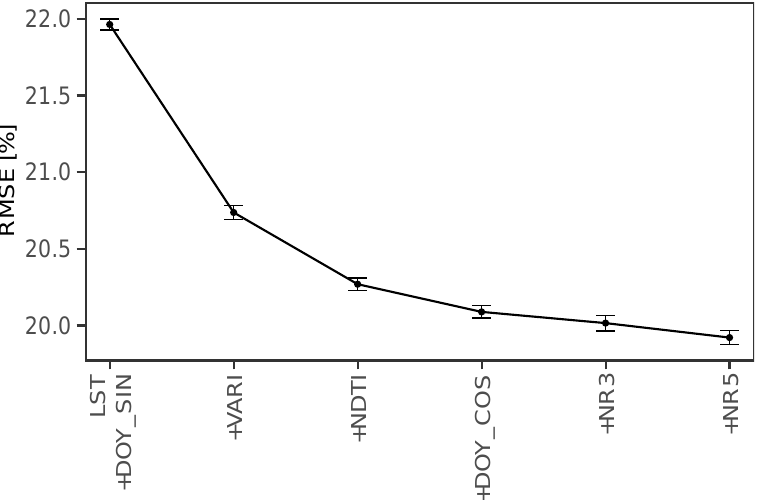
Figure 3. Selected variables derived from the combination of the Forward Feature Selection (FFS) process and the leave-location-out cross-validation (LLOCV). Black dots and vertical segments represent, respectively, the average LLOCV error and the standard error calculated from the 25 random forests computed at each FFS